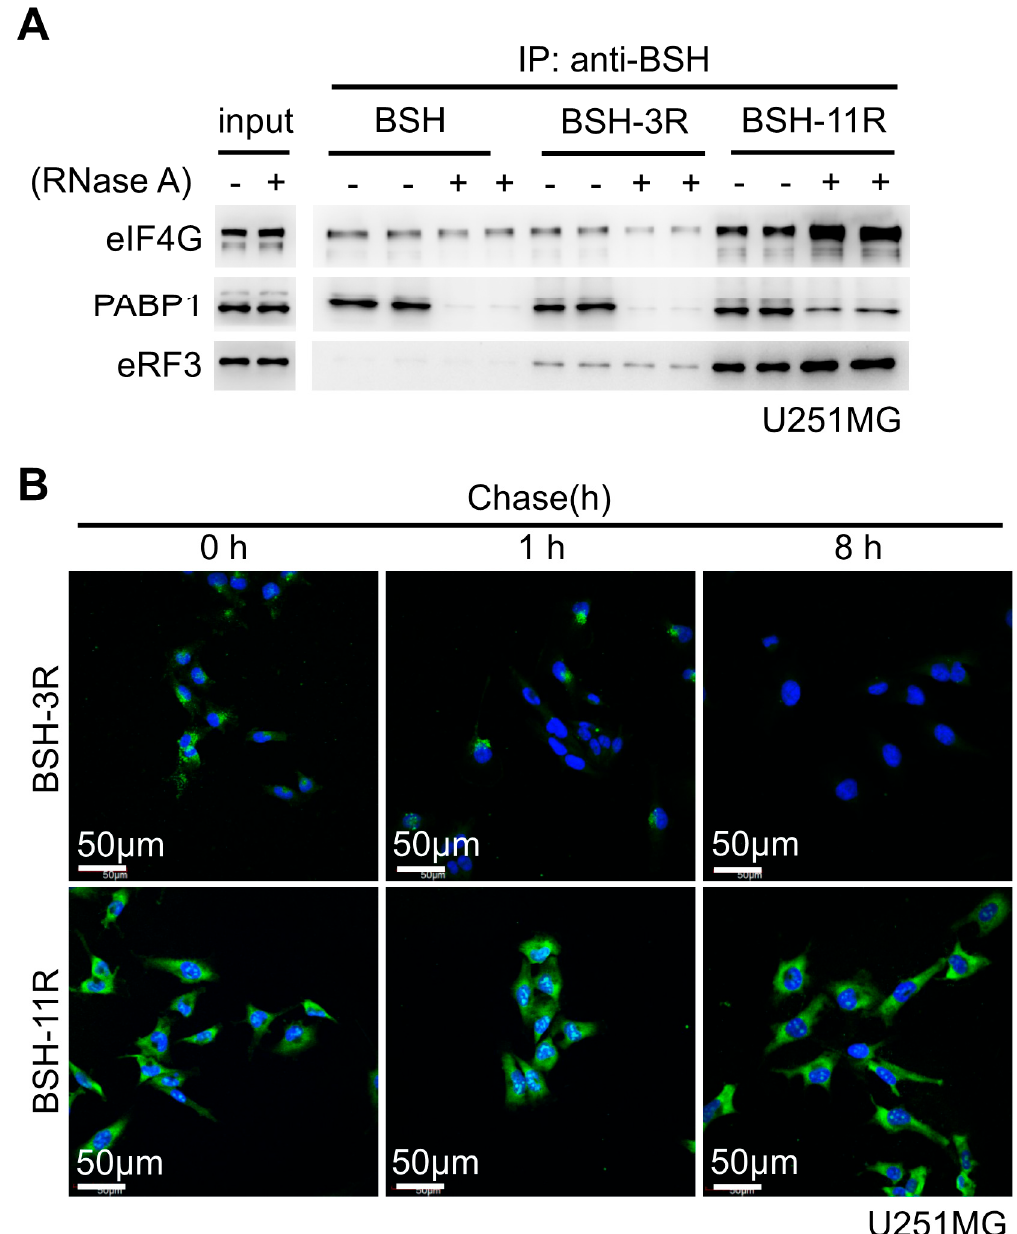
Figure 7. The molecular properties of BSH-polyR define the intracellular retention time of BSH-polyR. ( A ) The interactions between BSH-polyR and translation-related proteins were dependent on the length of arginine. ( B ) The polyR length affected the intracellular retention time of